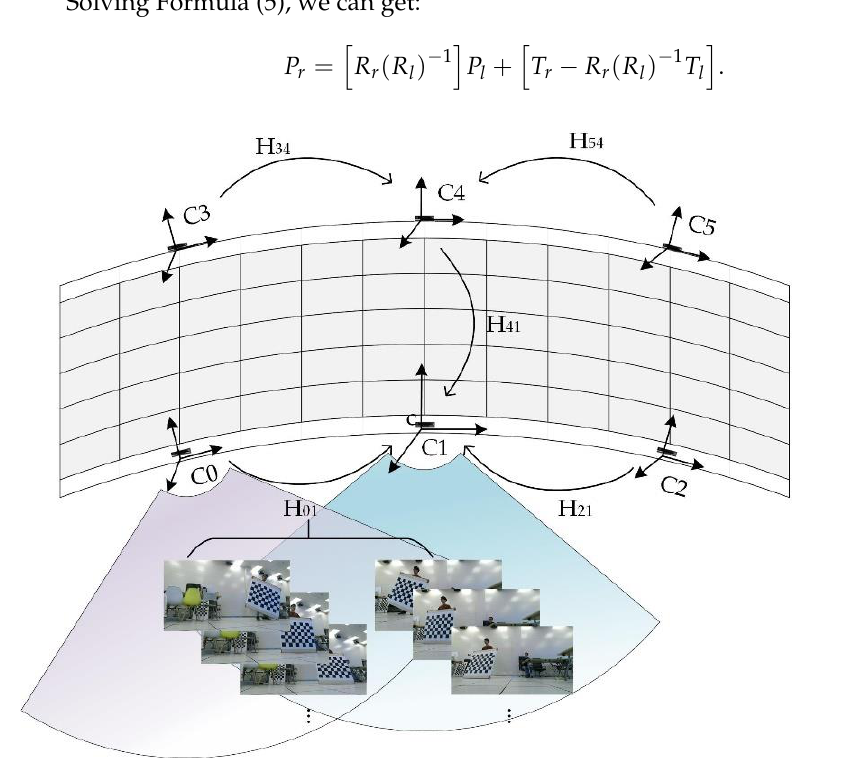
Figure 4. Uniform coordinate system.